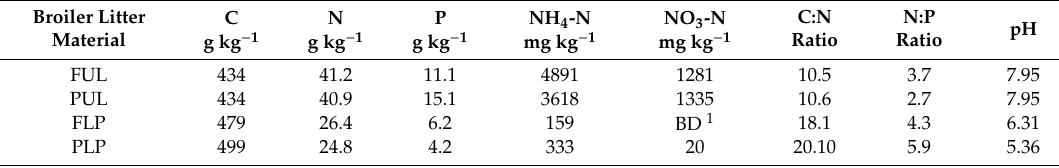
Table 2. Chemical properties of the four broiler litter materials: Fine untreated litter (FUL), pelletized untreated litter (PUL), fine low-P treated litter (FLP), and pelletized low-P treated litter (PLP). Data are average of two samples on a dry weight